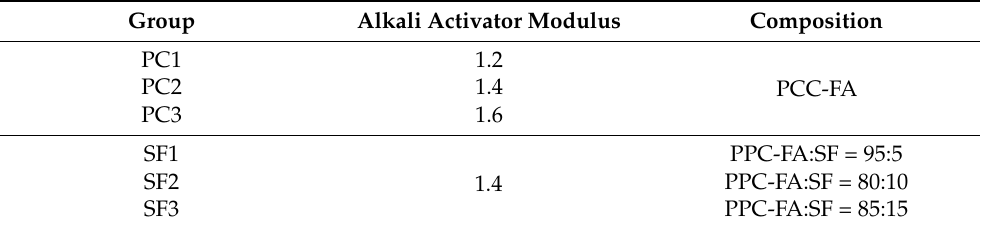
Table 3. Preparation parameters of AACMs with PCC-FA and SF. Group Alkali Activator Modulus Composition PC1 1.2 PCC-FAPC2